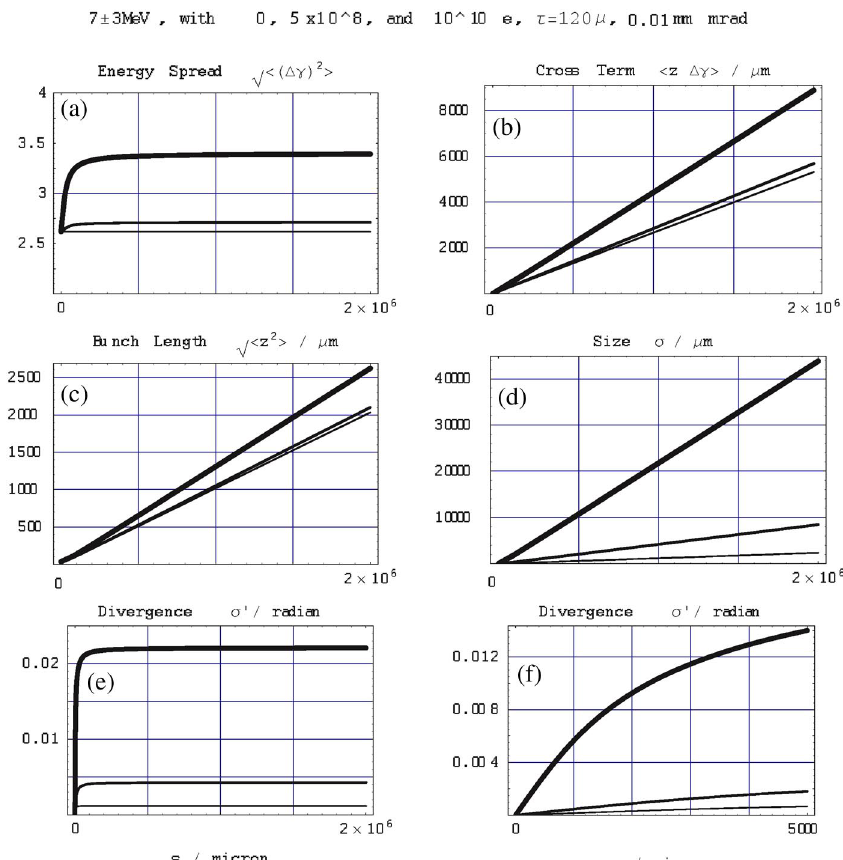
FIG. 2. (Color) Calculated longitudinal and transverse phase space evolution for three differ- ent charges N (cid:3) 0 , N (cid:3) 5 (cid:1) 10 8 , and N (cid:3) 1 (cid:1) 10 10 , respectively, in the order of the lines shown, all for an assumed bunch length (FWHM) of 120 (cid:4) m . The latter two charges are within the range reported from the experiments [1,2,4], and N (cid:3) 5 (cid:1) 10 8 is precisely the value reported in [2] for the collimated beam with collimation angle (cid:5) 2 : 5 mrad . Shown are, as in Fig. 1, the phase space parameters vs the drift lengths (in (cid:4) m ): (a) p (cid:1)(cid:1)(cid:1)(cid:1)(cid:1)(cid:1)(cid:1)(cid:1)(cid:1)(cid:1)(cid:1)(cid:1)(cid:1)(cid:1) h z 2 i(cid:6) s (cid:7) , (d) (cid:2) (cid:6) s (cid:7) , and (e),(f) (cid:2) 0 (cid:6) s (cid:7) . The sixth figure (f) is the same (cid:2) 0 of the fifth (e), except (c) that it is plotted for a shorter range in s to emphasize the initial short range development. The calculations were extended to a length of 2 m, because the experiment [2] collimated and measured the beam at this distance. Initial condition for (cid:2) is (cid:2) (cid:6) 0 (cid:7) (cid:3) 8 : 5 (cid:4) m , the radius of the laser-plasma channel in this case [2]. Assumption of (cid:2) 0 (cid:6) 0 (cid:7) (cid:3) 0 was found to be compatible for agreement between calculations and experiments, (cid:2) 0 (cid:6) 0 (cid:7) (cid:1) 0 was not. All units for z , (cid:2) , and s are in microns, divergences (cid:2) 0 (cid:6) s (cid:7) are given in radian. And finally, assuming (cid:1) 0 : 01 mm mrad seems to be in better agreement with the experiment than a substantially larger value, while a substantially smaller value had no effect on the calculation (see Fig.